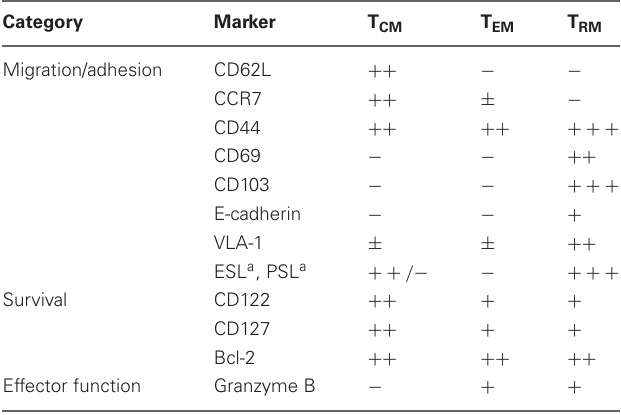
Table 2 | Phenotypic differences between CD8 + memory T cell